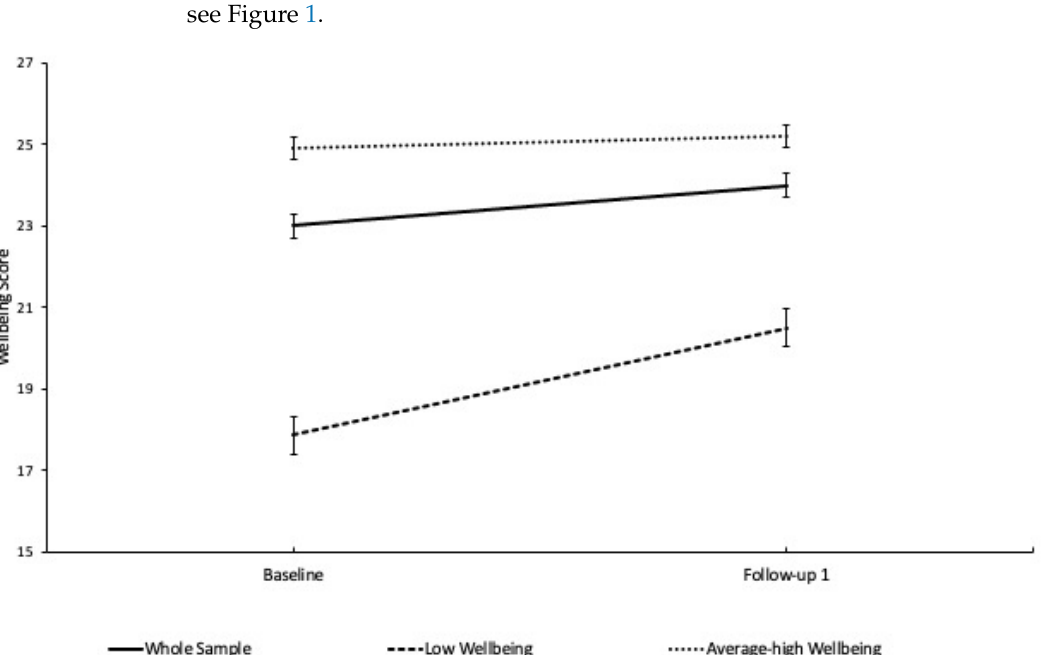
Figure 2. Mean ( ± SEM) SWEMWBS scores at baseline and follow up (on average 4.5 months Figure 2. Mean (±SEM) SWEMWBS scores at baseline and follow up (on average 4.5 months later).